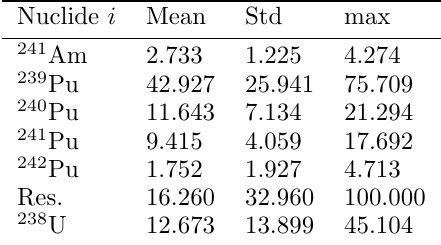
Table 4. Mean, Std and maximum values of the fractions f i for neutron absorption of some nuclides from the MOX dataset.